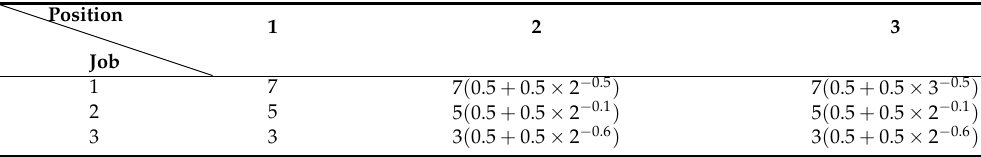
Table 1. Processing time of the group G 1 jobs in different positions.